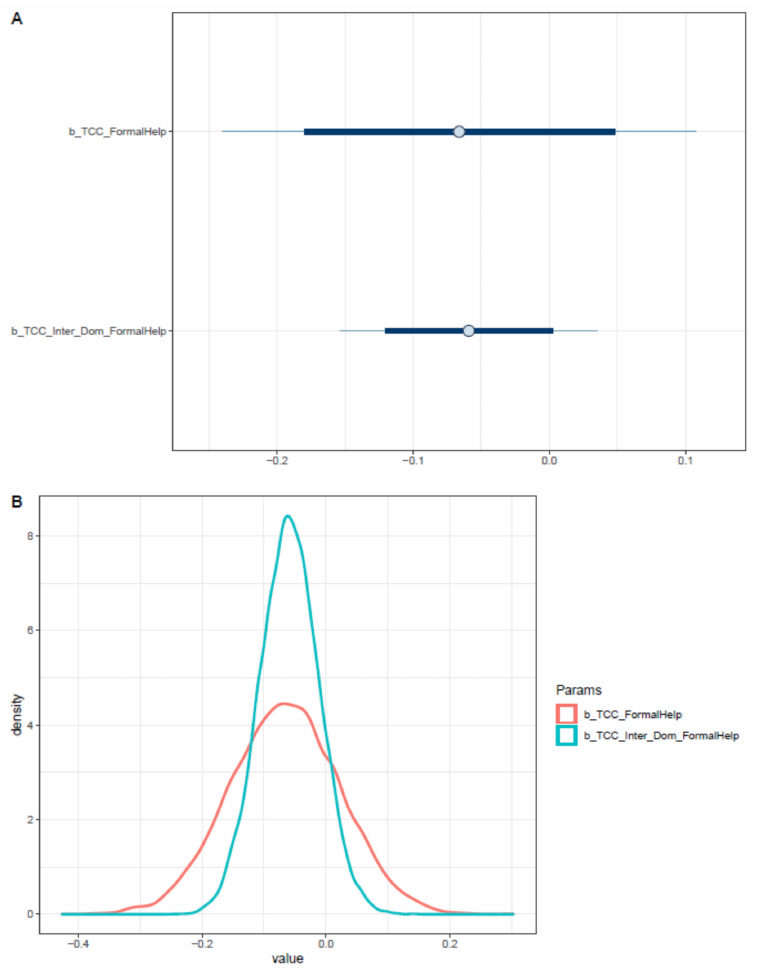
Figure 14. Distributions of Model 3 (cid:48) s posterior coefficients. ( A )—Interval plot; ( B )—Density plot.